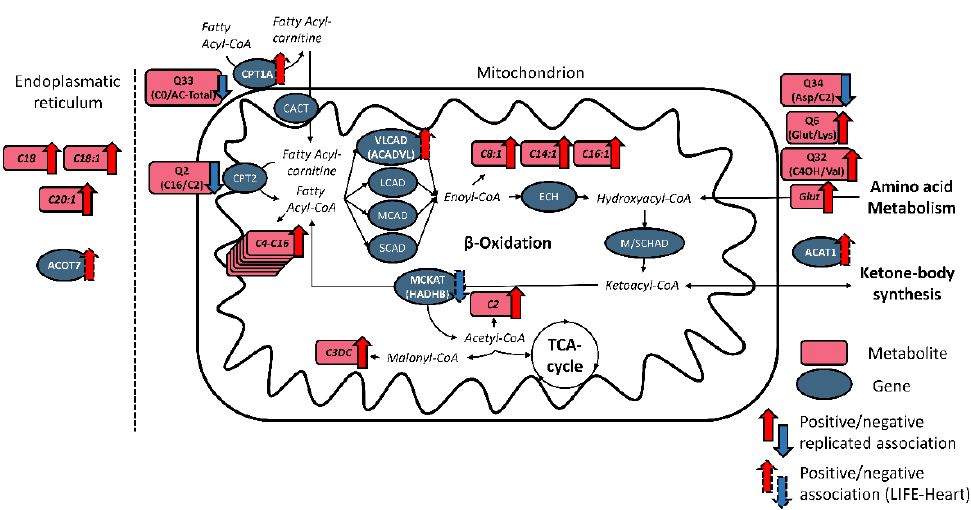
Figure 2. Metabolites (red) and expression of genes (blue) of fatty acid oxidation associated with NT-proBNP in both studies. Replicated (significant after hierarchical FDR = 5% and equal direction of effect) associations are indicated by an arrow showing the direction of effects. Associations only found in LIFE-Heart are indicated by a dashed arrow. Involved pathways comprise reactions in the endoplasmic reticulum or the mitochondrion. For each associating feature, the direction of effect is indicated by an upward (red) or downward (blue) arrow for positive or negative association of the metabolite with NT-proBNP. Most metabolite/gene associations affect mitochondrial β -oxidation. Very long, long- medium- and short-chain acylcarntines accumulate with increasing NT-proBNP, as well as acetylcarnitine (C2) and malonylcarnitine (C3DC). Increase of glutarylcarnitine (Glut) and several ratios (Q6:Glut/Lys, Q32:C4OH/Val, Q34:Asp/C2) indicate increased mobilization of amino